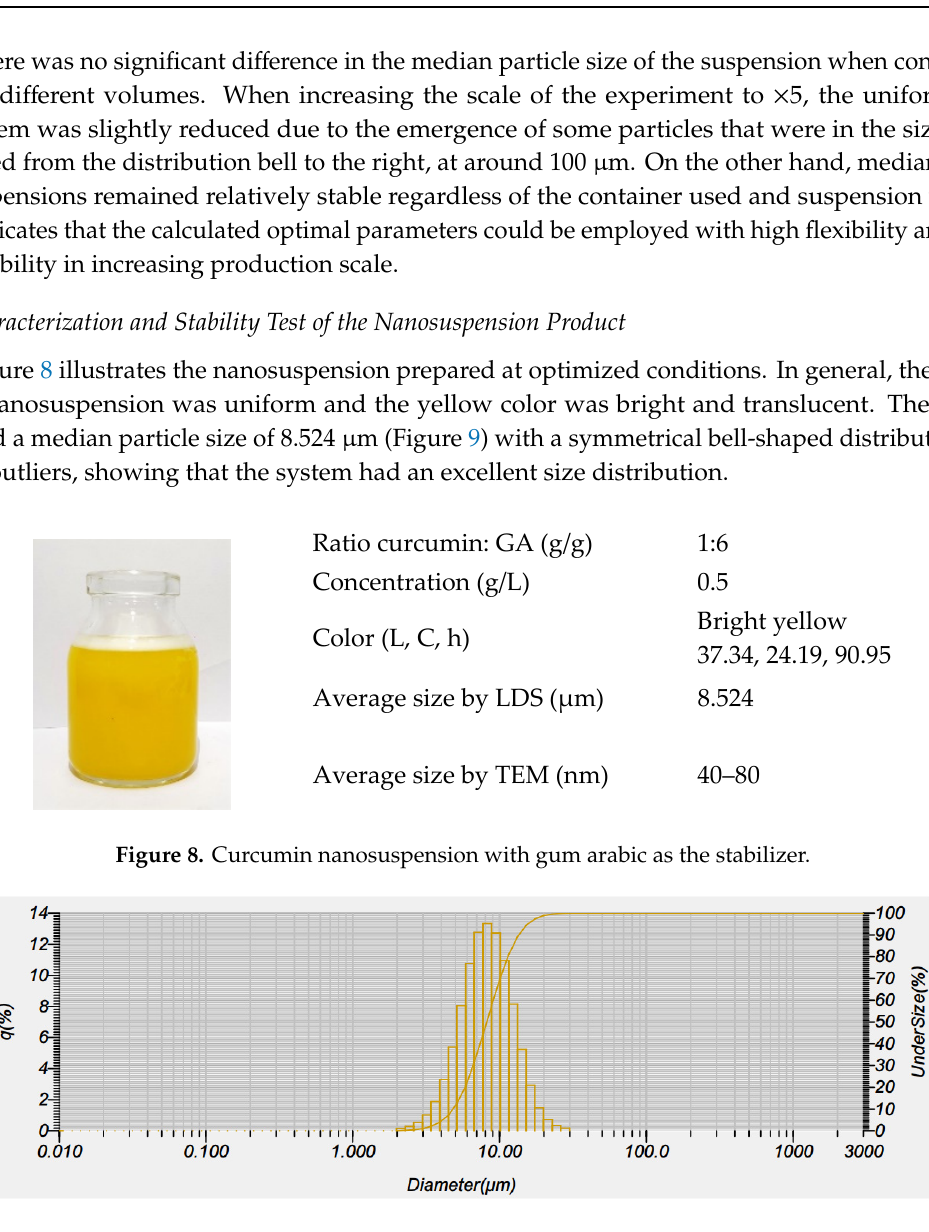
Figure 9. Size distribution of curcumin nanosuspension analyzed by laser diffraction spectrometry